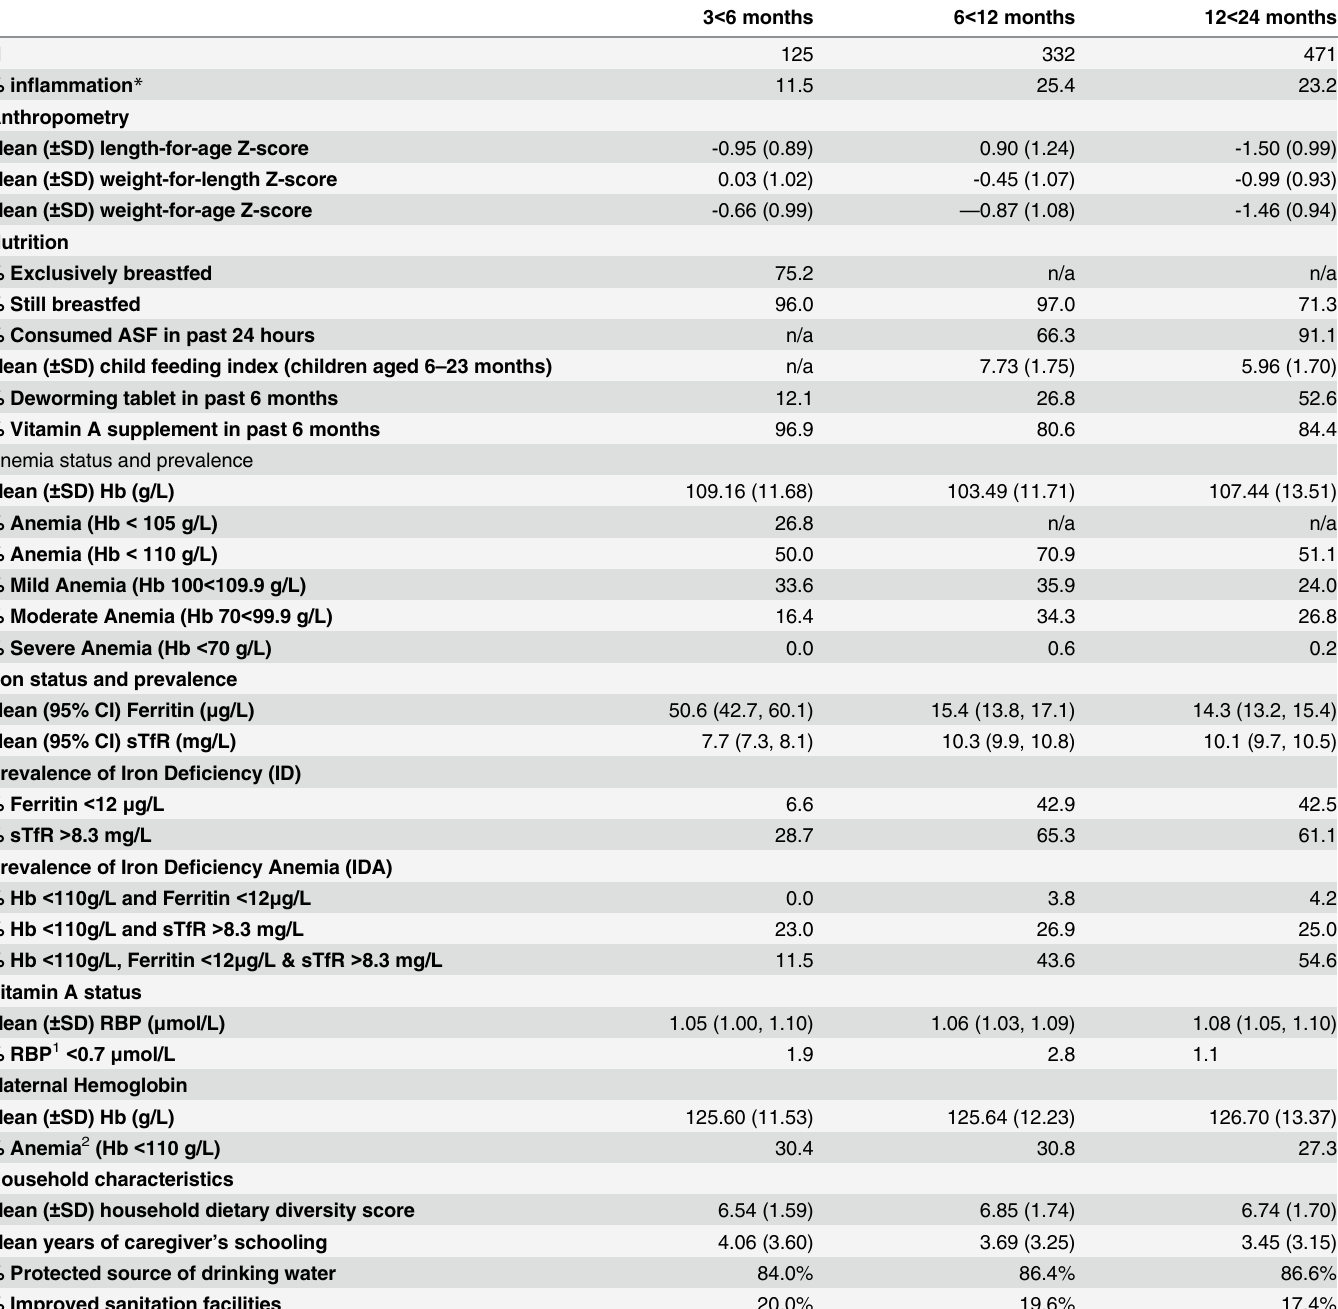
Table 2. Main child characteristics: anthropometry, IYCF, and micronutrient